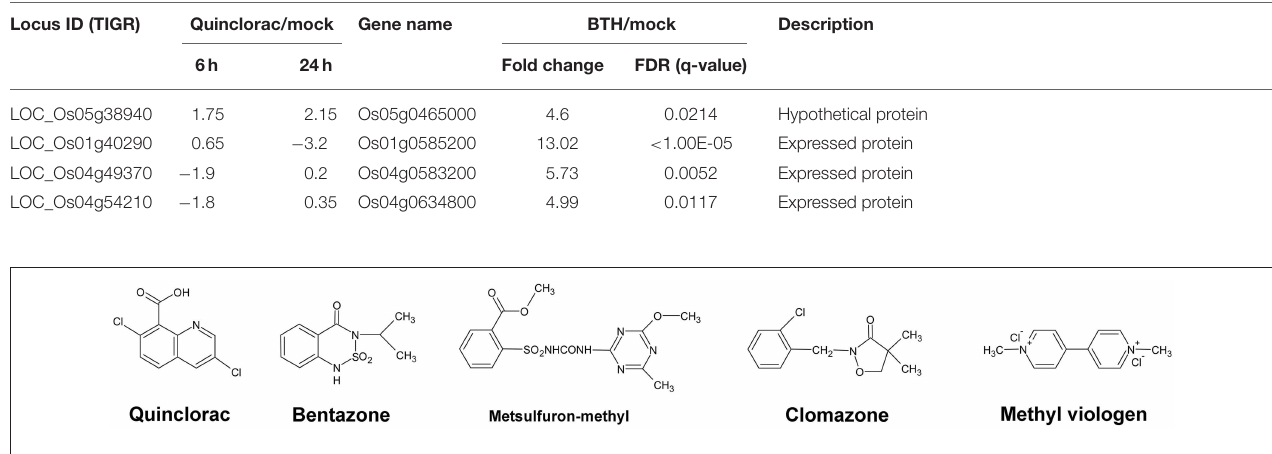
FIGURE 4 | The chemical structures of five